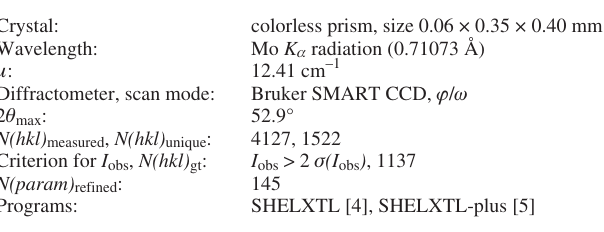
Table 1. Data collection and handling.